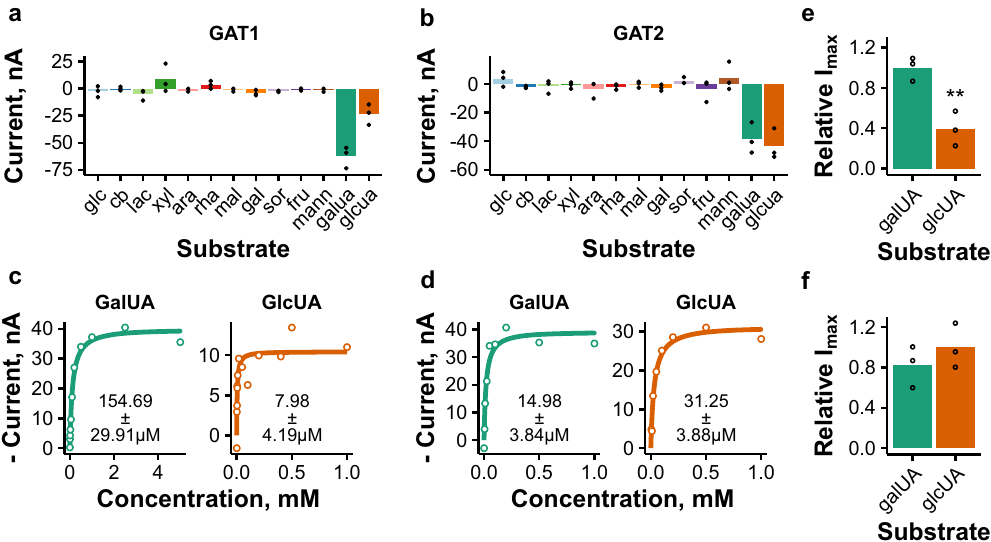
Figure 6. Electrophysiological characterization of uronic acid transporters GAT1 and GAT2. ( a , b ) Selectivity plots of GAT1 ( a ) and GAT2 ( b ) measured by recording currents in the presence of different sugars and sugar acids in 5 mM concentration (abbreviations as in Fig. 1). Results obtained with − 50 mV test voltage are shown. Points present results obtained from individual oocytes and bars their mean ( n = 3 ). ( c , d ) Sugar acid transport kinetics of GAT1 ( c ) and GAT2 ( d ) at − 50 mV. Representative experiments are shown. Lines present the Michaelis Menten kinetics prediction and the K m values present the mean and standard deviation from individual oocytes ( n = 3 ). ( e , f ) Relative I max values for GAT1 ( e ) and GAT2 ( f ) at − 50 mV. I max values from individual oocytes were normalized to the mean I max value of the substrate with the highest I max value for each transporter. Points present results from individual oocytes and bars their mean ( n = 3 ). Significance was estimated with Student’s t -test (** : p < 0.01 ). The figure was created with ggplot2 package for R 79,85